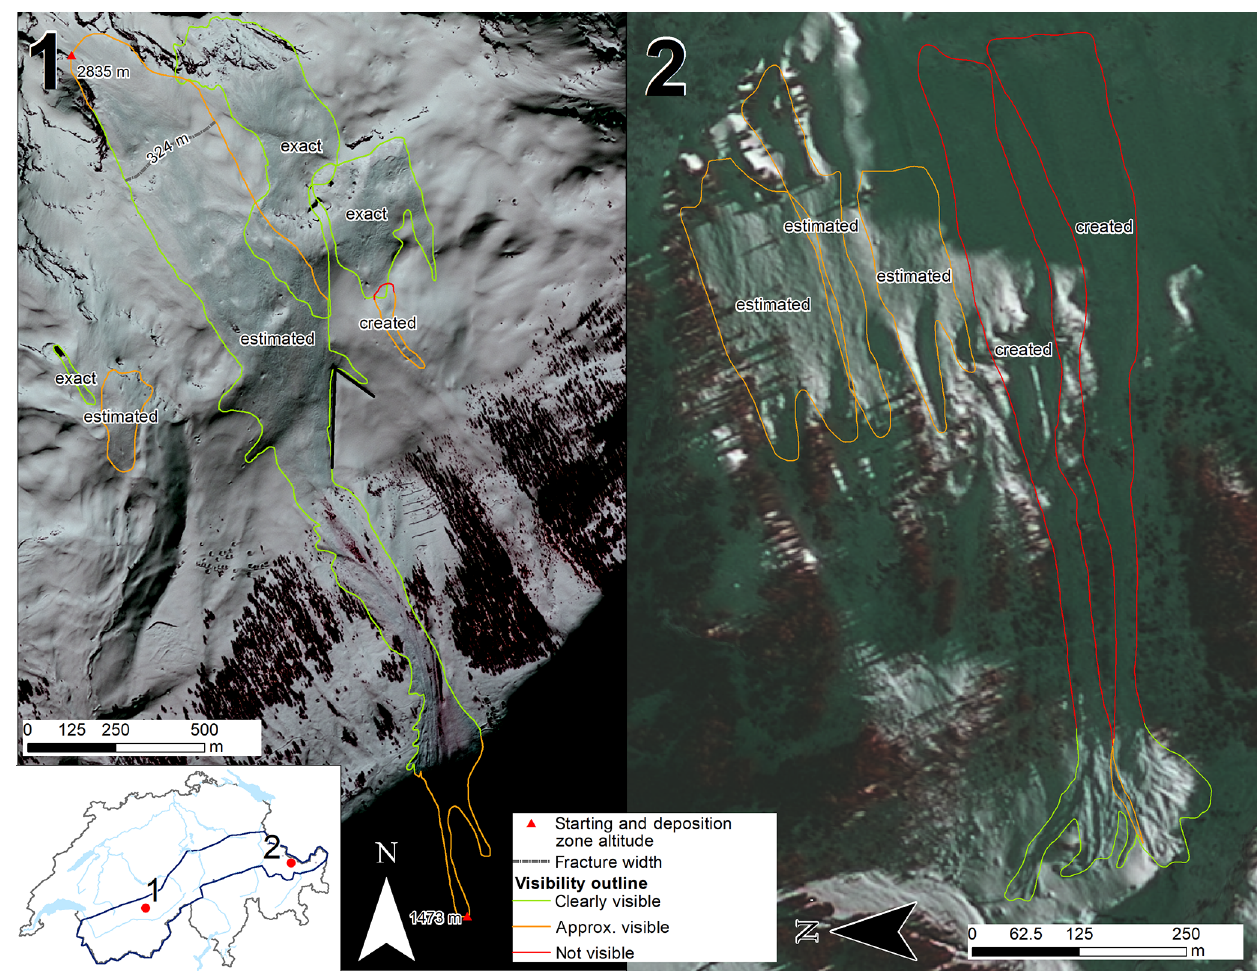
Figure 2. Examples of mapped avalanches in imagery optimized for brightly illuminated areas (1) and for regions with shaded areas (2). The colors of the outline indicate the visibility of different sections and the resulting attribute “quality outline” for each avalanche. The visibility tends to be poorer for areas in the shade. For the largest avalanche in (1), the “position of measurement” of the height of start and deposition altitude are shown as well as the origin and length of fracture width (see Table 2 for definition of those attributes). A deflection dam that worked well by changing the flow path of the avalanche is marked as a black line in (1). Overlapping avalanche area, as in (1), is determined by interpretation of the flow direction from the topographic map and by differences in contrast between different depositions. (SPOT6 data © Airbus DS